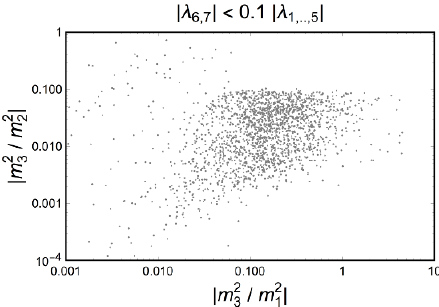
Figure 4 . The relative size of the mass parameters of the scalar potential satisfying the condition (cid:21) 6 ; 7 < 0 : 1 (cid:21) 1 ; 2 ; 3 ; 4 ; 5 .